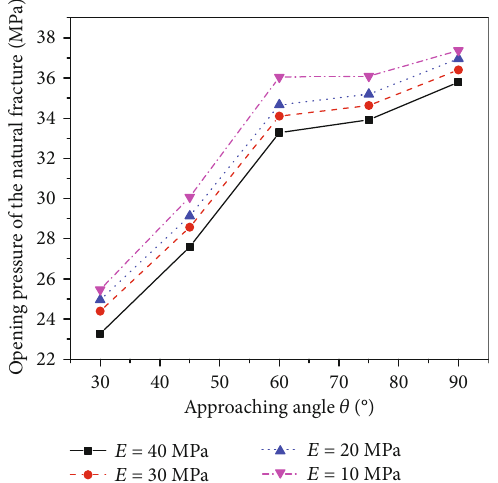
Figure 11: Opening pressure of the natural fracture under di ff erent Poisson ’ s